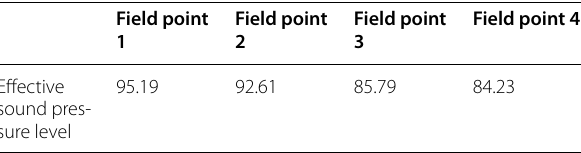
Table 2 Effective sound pressure level of radiated noise at